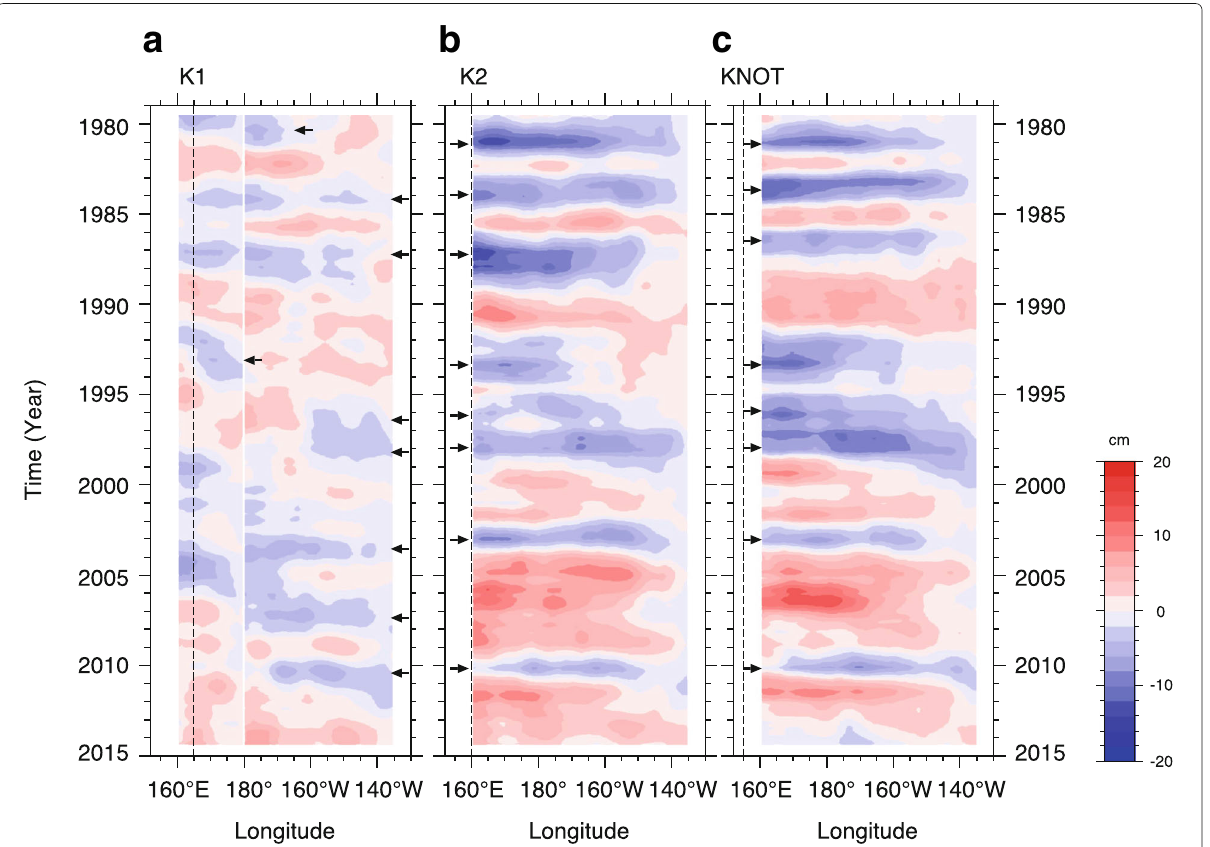
Fig. 11 a – c Same as Fig. 9 but for the SSH variations calculated from the NCEP/NCAR wind stress data from 1979 to 2014. In panel a , the wind stress data in the region east of 180° were not used for the calculation of the SSH anomaly in the western region. Arrows show El Niño-related SSH